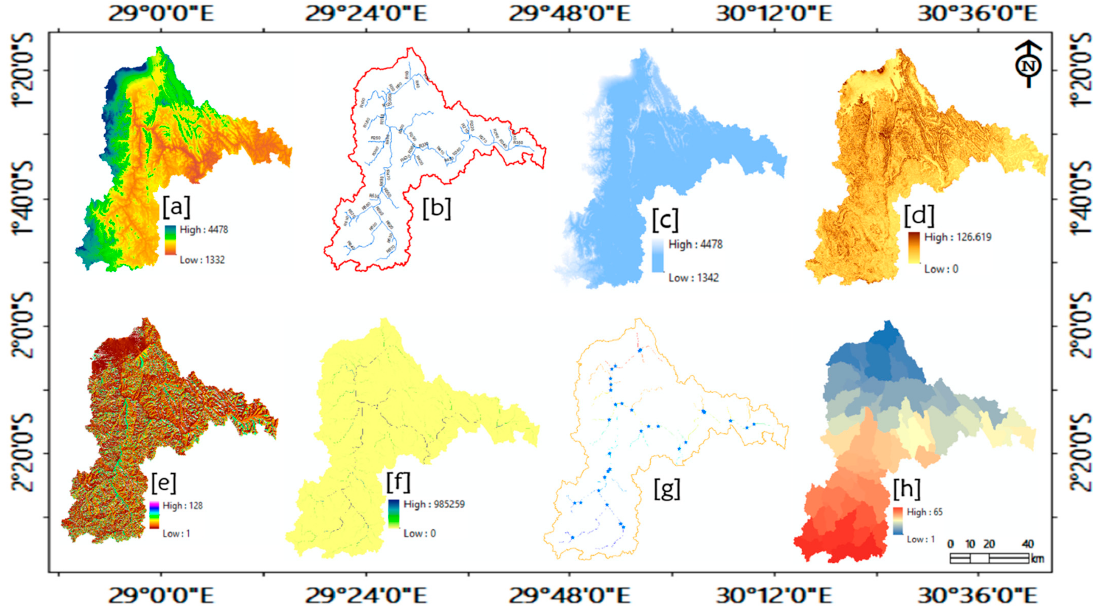
Figure 3. Input geospatial datasets from terrain preprocessing for catchment delineation: ( a ) Reconditioned DEM; ( b ) Streams; ( c ) Filled sinks; ( d ) Slope; ( e ); Flow direction ( f ) Flow accumulation; ( g ) Defined stream segmentation and drain- age points; ( h ) Catchment grid delineation.